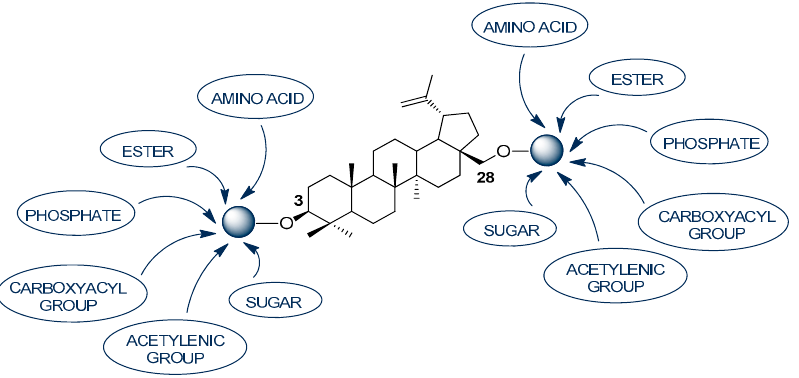
Figure 1. The selected modifications of the BN skeleton at positions C-3 and C-28 [3–5].